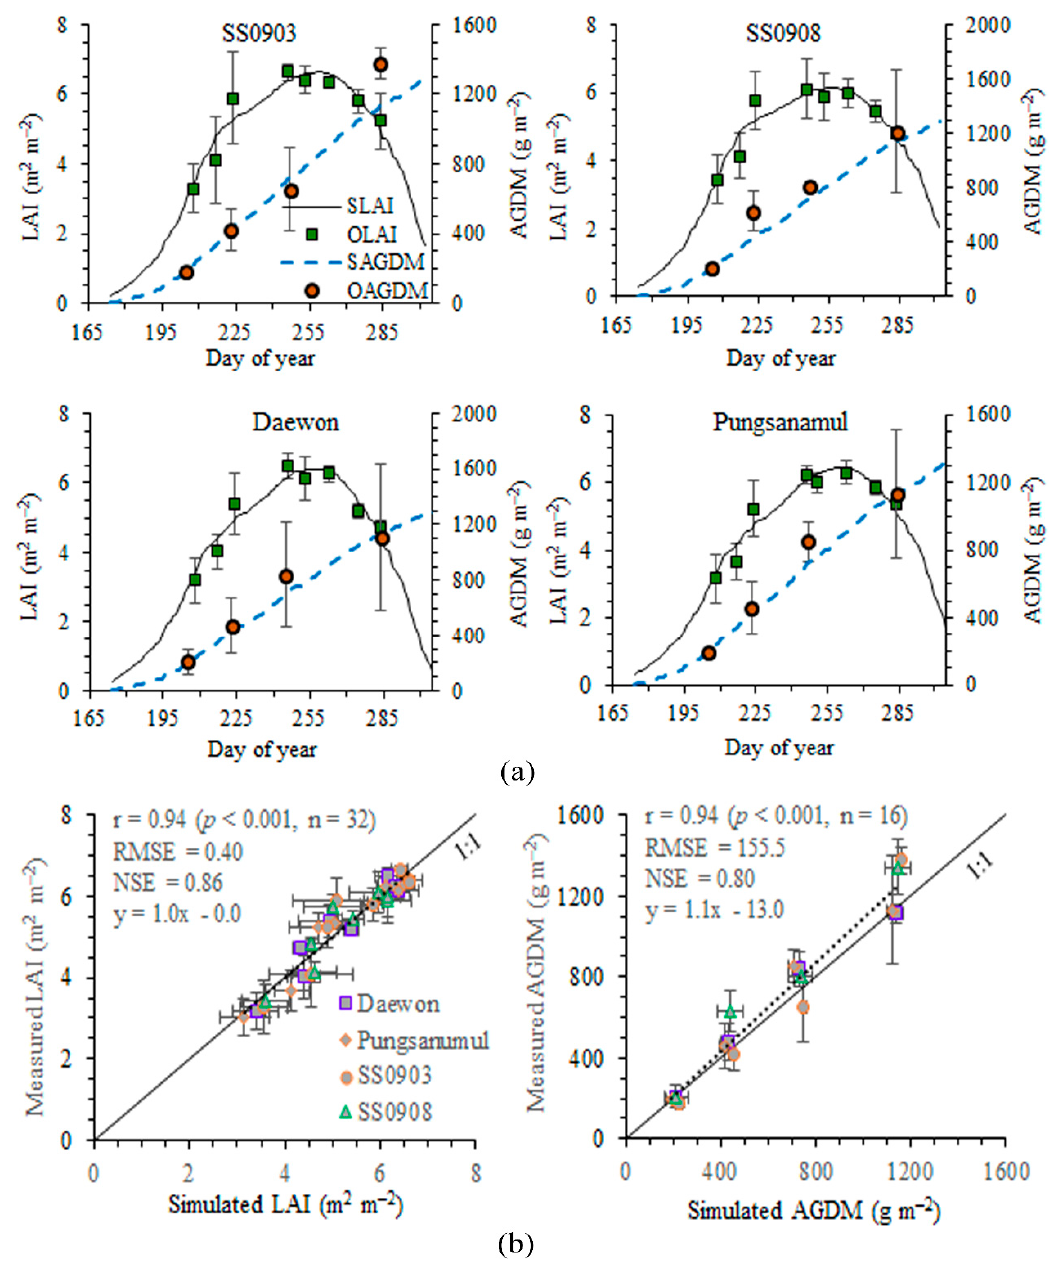
Figure 3. Model calibration: Simulated (S) and measured (M), observed (O) LAI and above-ground dry mass (AGDM) for four soybean germplasms or cultivars, SS0903, SS0908, Daewon, and Poongsanamul based on the leaf area index (LAI) input option ( a ) and comparisons between S and M values for LAI and AGDM ( b ). Data were obtained at Chonnam National University, Gwangju, South Korea, in 2017. Vertical and horizontal error bars represent the standard deviations ± 1 SD of the mean values. The solid and dotted lines in the panel ( b ) represent the ratio 1:1 and a linear fit, respectively. NSE, RMSE, and r denote Nash-Sutcliffe efficiency, root mean square error, and Pearson’s correlation coefficient, respectively.